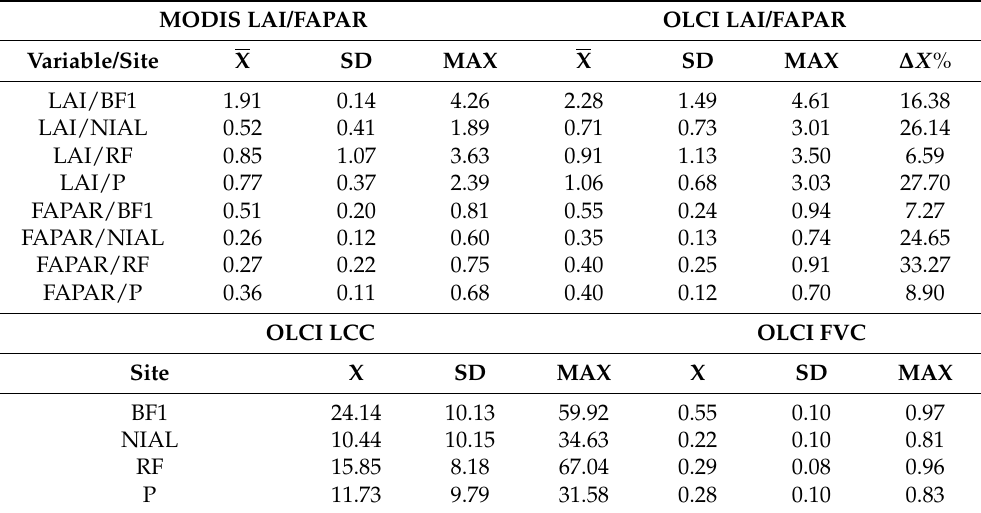
Table 4. Summary statistics over temporal window (April 2016–November 2020) for LAI, FAPAR, LCC and FVC, refered to CLC areas. LAI and FAPAR of the S3-TOA-GPR-1.0 models are compared against MODIS MCD15H products with percentage differences of time series means ( ∆ X %). MODIS LAI/FAPAR OLCI LAI/FAPAR Variable/Site X SD MAX X